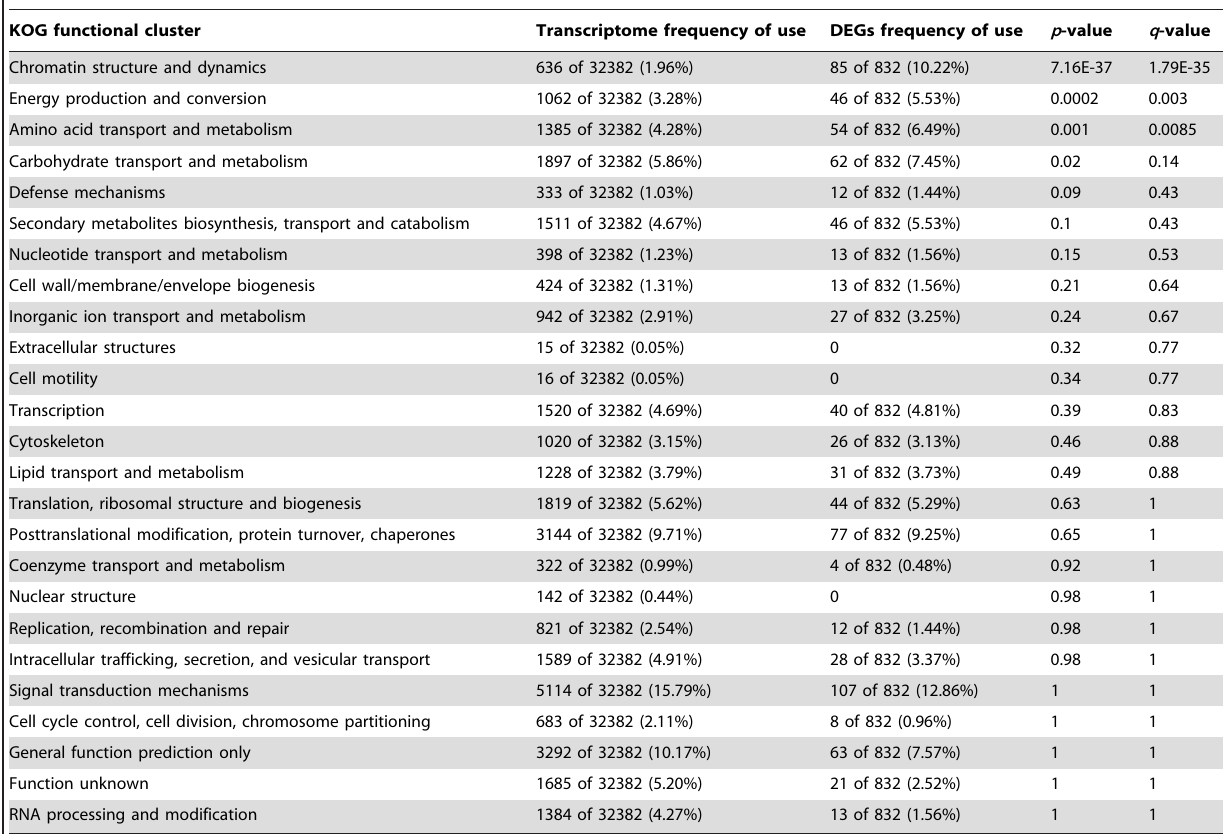
Table 1. KOG enrichment analysis of the wounding-responsive DEGs compared with the reference transcriptome.